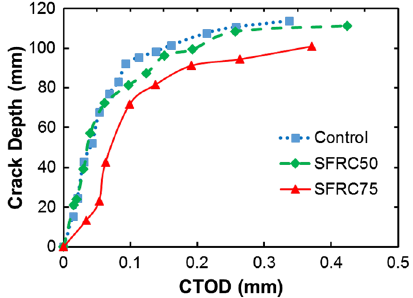
Fig. 12 Depth of crack extension with CTOD for control, SFRC50 and